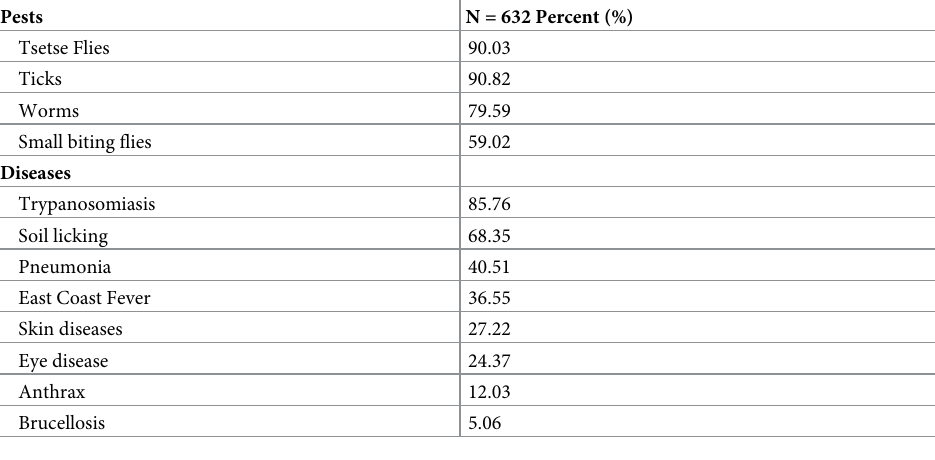
Table 3. Livestock pests and diseases in Kwale